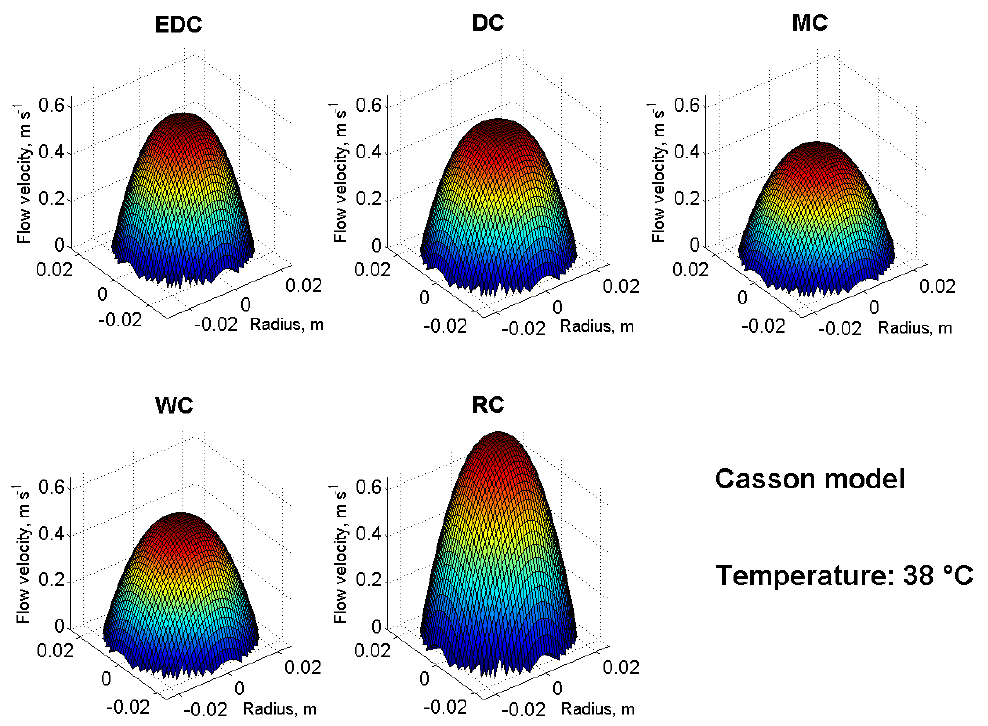
Figure 4. 3D velocity profiles of the chocolate masses at 38 °C using the Casson model.